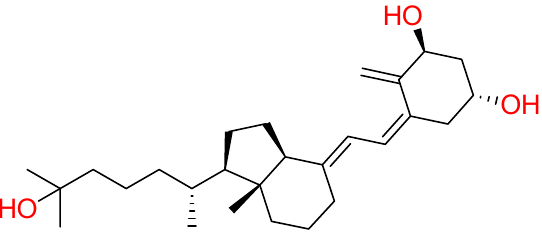
Figure 1. 2D structure of calcitriol (Vitamin